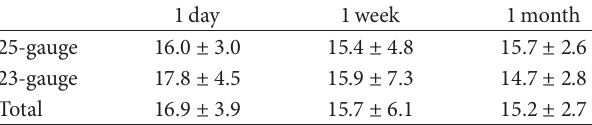
Table 3: Postoperative changes in intraocular